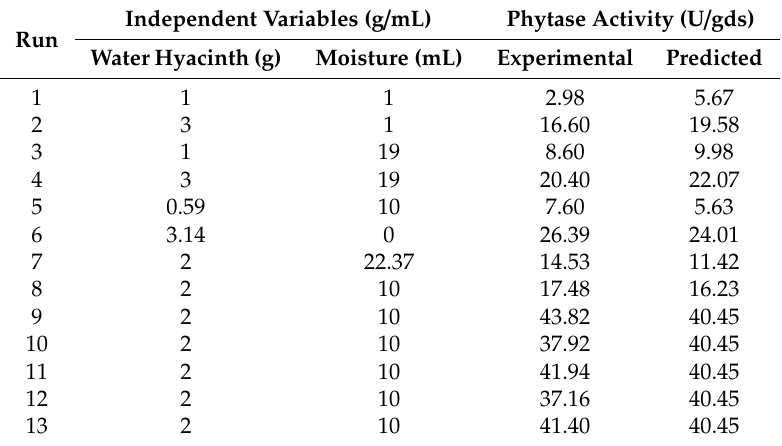
Table 2. The experimental design and responses for optimization of phytase activity with P. adiposa using